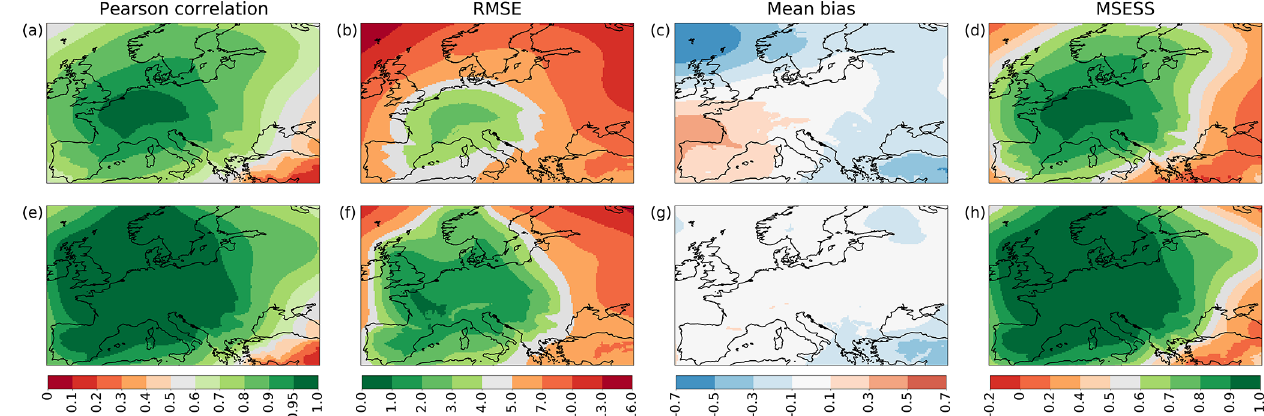
Figure 3. Validation of sea level pressure over time for winter months NDJF in the period 1950–2020 for the ARM (a–d) and EnKF (e– h) reconstructions. The reconstructions are compared vertically by validation metrics: shown are the Pearson correlation coefficient (a, e) ,